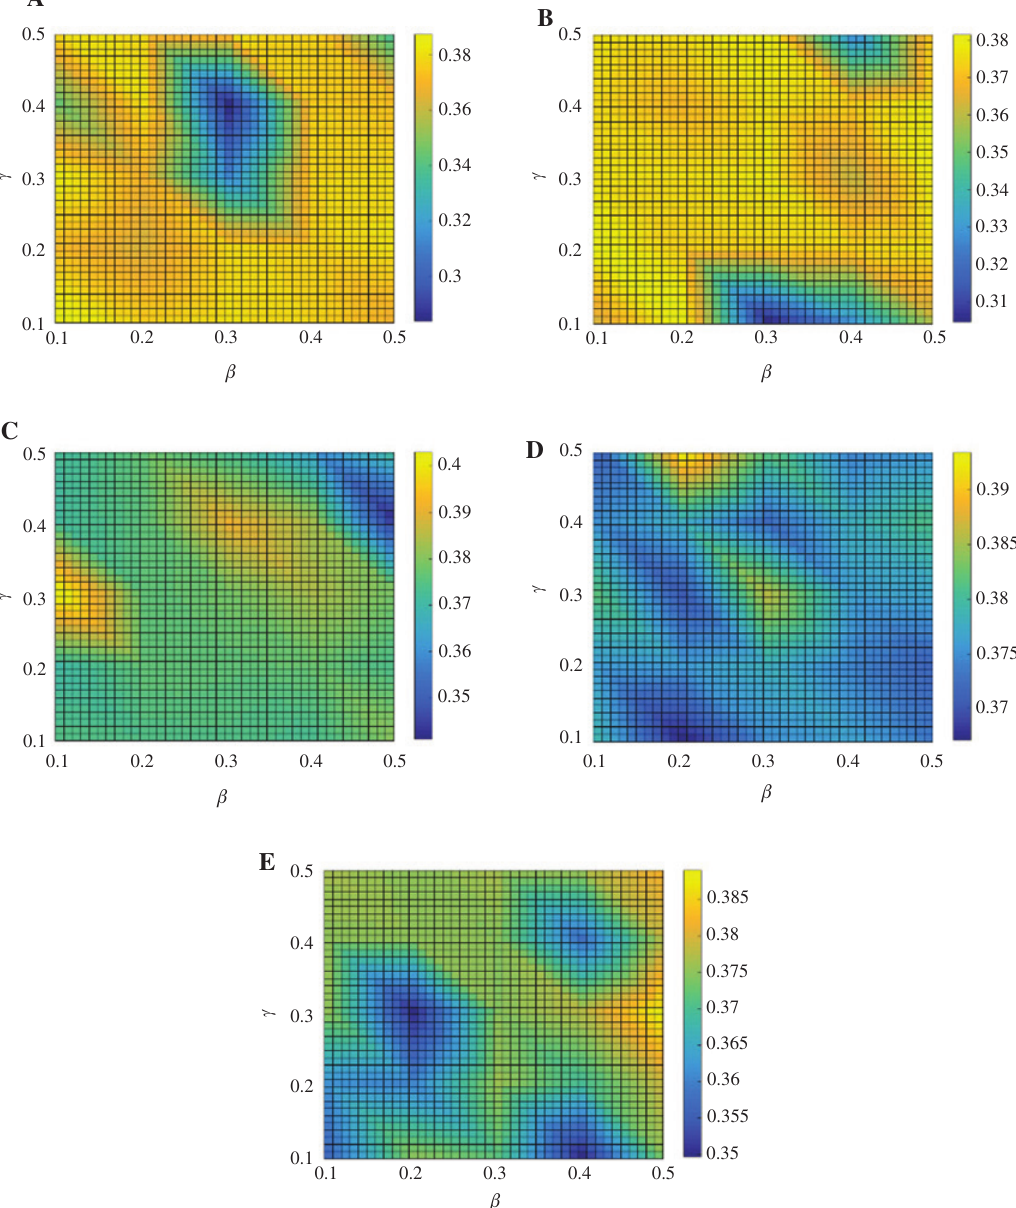
Figure 10: Estimation of Temperature Outlet under Varying β and γ with the Reference of α as (A) 0.1, (B) 0.2, (C) 0.3, (D) 0.4, and (E)